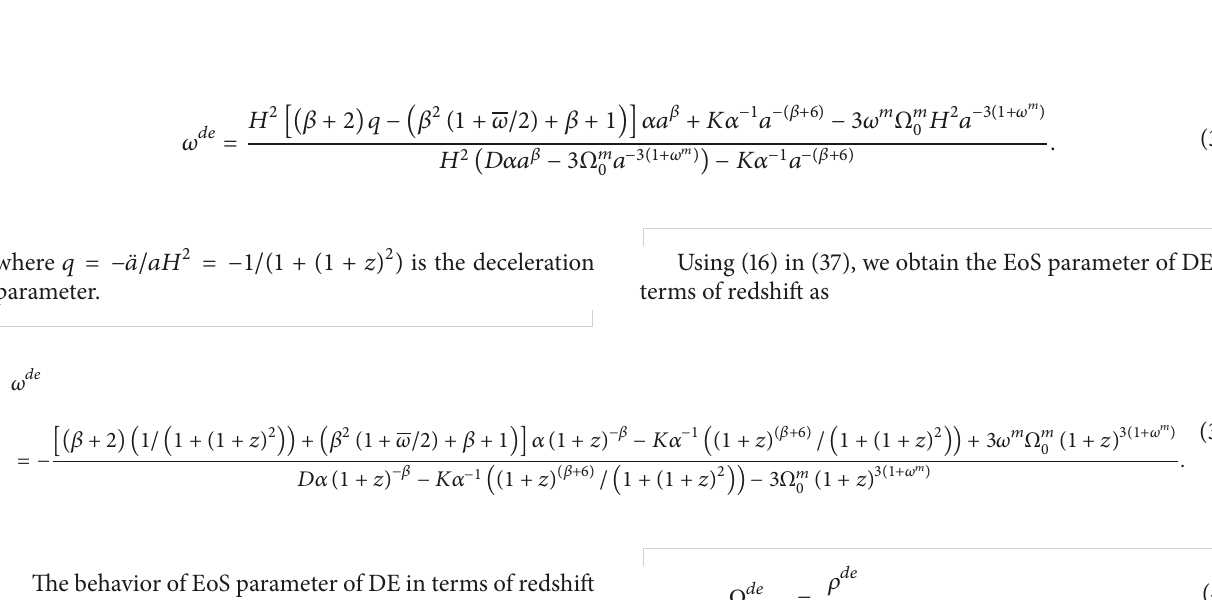
Figure 1: The plot of EoS parameter 𝜔 𝑑𝑒 versus redshift 𝑧 for 𝛼 = 1 , 𝛽 = 0.01 , Ω 𝑚 0 = 0.3 , 𝜔 𝑚 = 0 , 𝜔 = 2 , and vary 𝐾 = 0.01 , 0.05, 0.09,